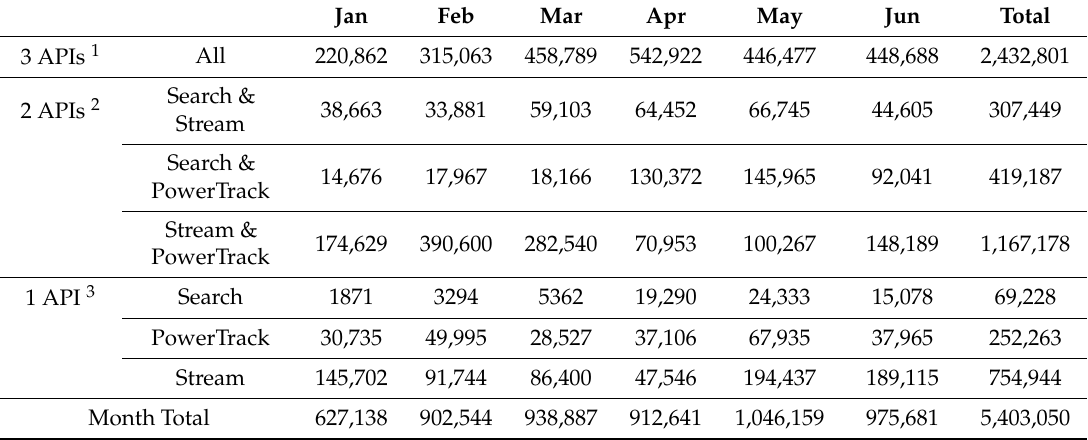
Table A1. Monthly volume of overlapping tweets between the APIs, combining all three topics. Jan